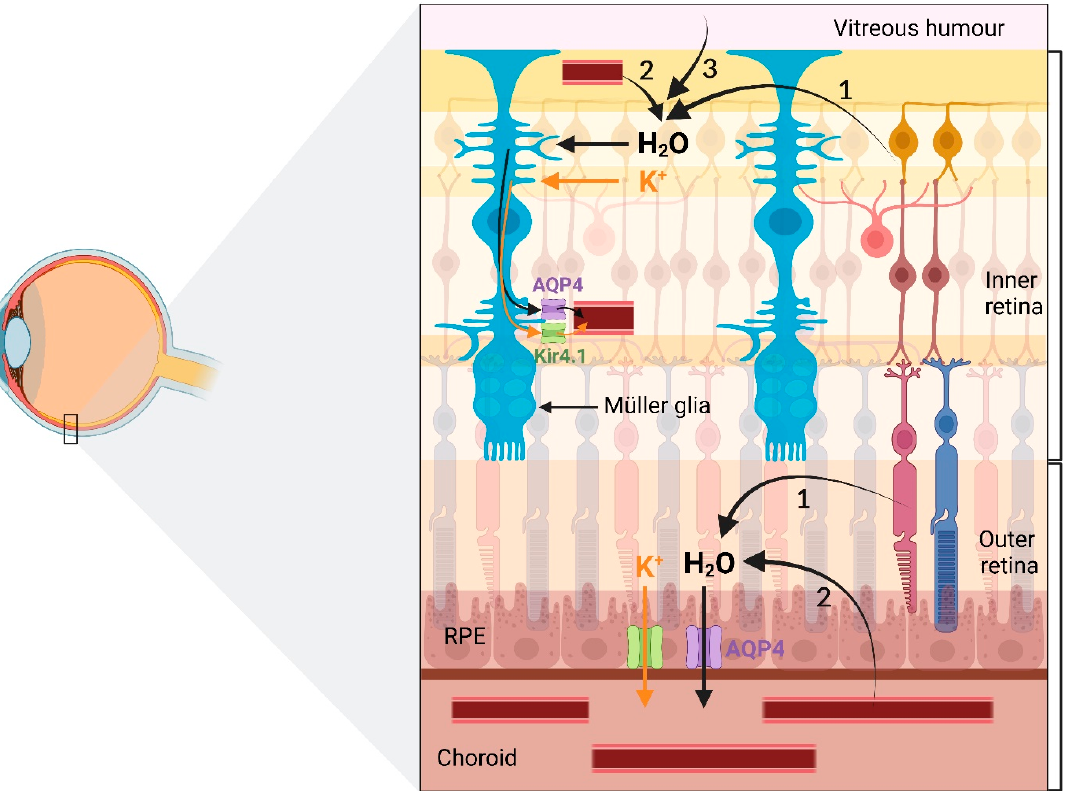
Figure 2. Retinal fluid regulation pathway. Under normal conditions, water accumulates in the retina due to (1) metabolic activity, (2) influx from blood, and (3) influx from the vitreous chamber. Müller glia and RPE cells are responsible for water clearance from the inner and outer retina, respectively. This transcellular water transport is facilitated by the AQP4 water channel and is coupled to transport of potassium ions (K + ) through the K + channel. Figure inspired from [25].